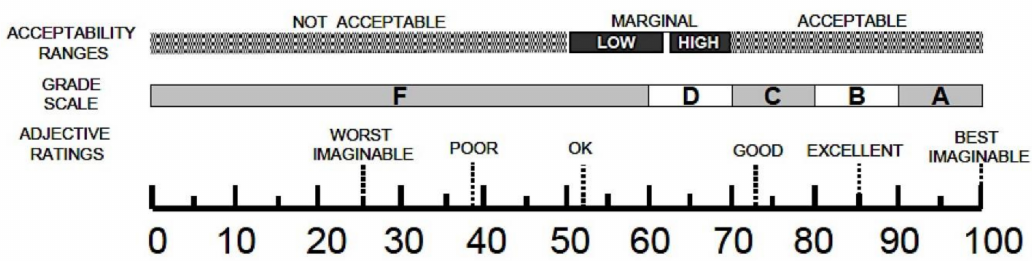
Figure 3. Comparison of the adjective ratings, acceptability scores and school grading scales, in relation to the average SUS score